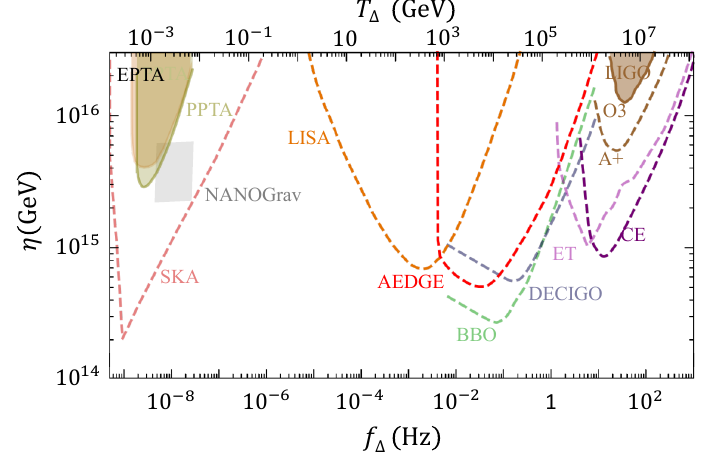
Figure 7 . Another illustration for f ∆ - T ∆ relation for GW frequency spectrum from global strings, where the experimental sensitivities to η are